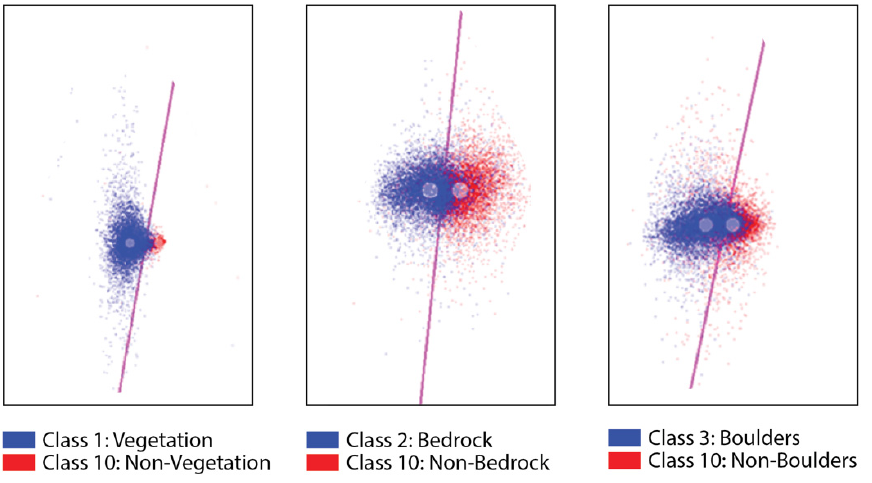
Figure 4. Semi-supervised classifier training result for identified features within natural channels. Data are projected in the plain of maximal separability and the spheres represent each class in the plane of maximal separability. The classification boundary is represented by magenta line and the core points extracted from the point cloud are shown. Greater point mixing between this line indi- cates a poorer performing classifier file. Class 1 shows vegetation and non-vegetation, a strong per- forming classifier file with little overlap between the classification boundary. classifier file with little overlap between the classification